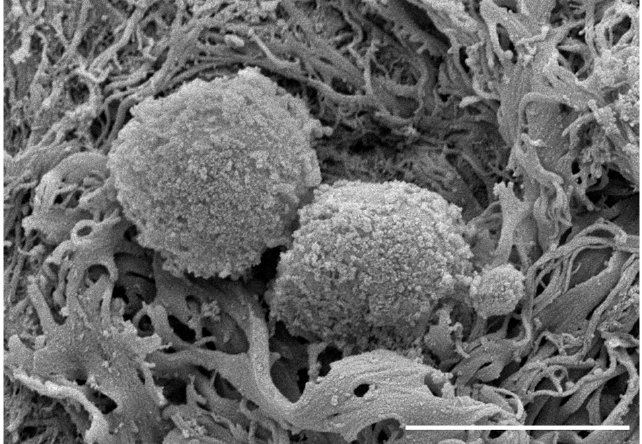
Figure 5. Visualization of cartilage with C28/I2 chondrocytes on decellularized scaffold by scanning electron microscopy. Cells attached to scaffold after 1 week in culture. Scale bar = 20 µm.